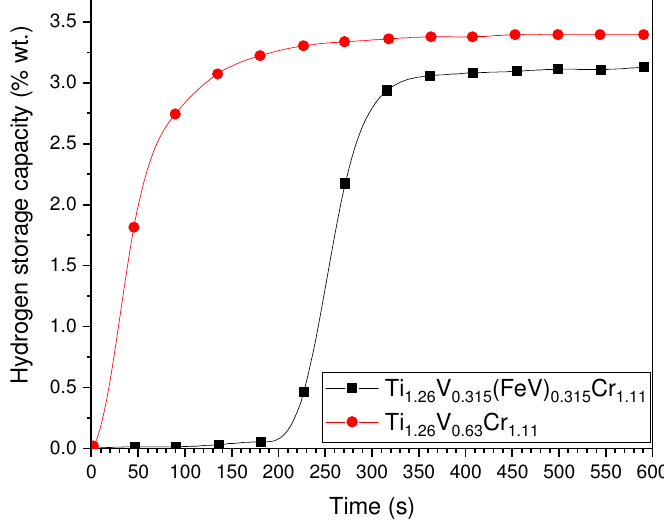
Figure 9. Activation under 20 bars of H 2 at 25 °C of the co-melt Ti 1.26 V 0.315 (FeV) 0.315 Cr 1.11 + 4% Zr 7 Ni 10 and co-melt Ti 1.26 V 0.63 Cr 1.11 + 4% Zr 7 Ni 10 .